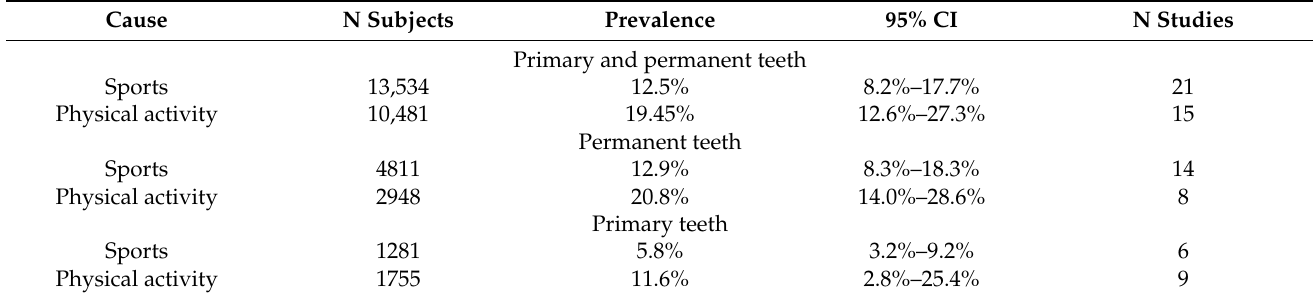
Table 2. Prevalence of traumatic dental injuries for permanent and primary teeth around the world. On the first column, sport and physical activity are reported as the causes of injuries. The last column indicates the number of studies used for this data. Adapted from “Textbook and Color Atlas of Traumatic Injuries”